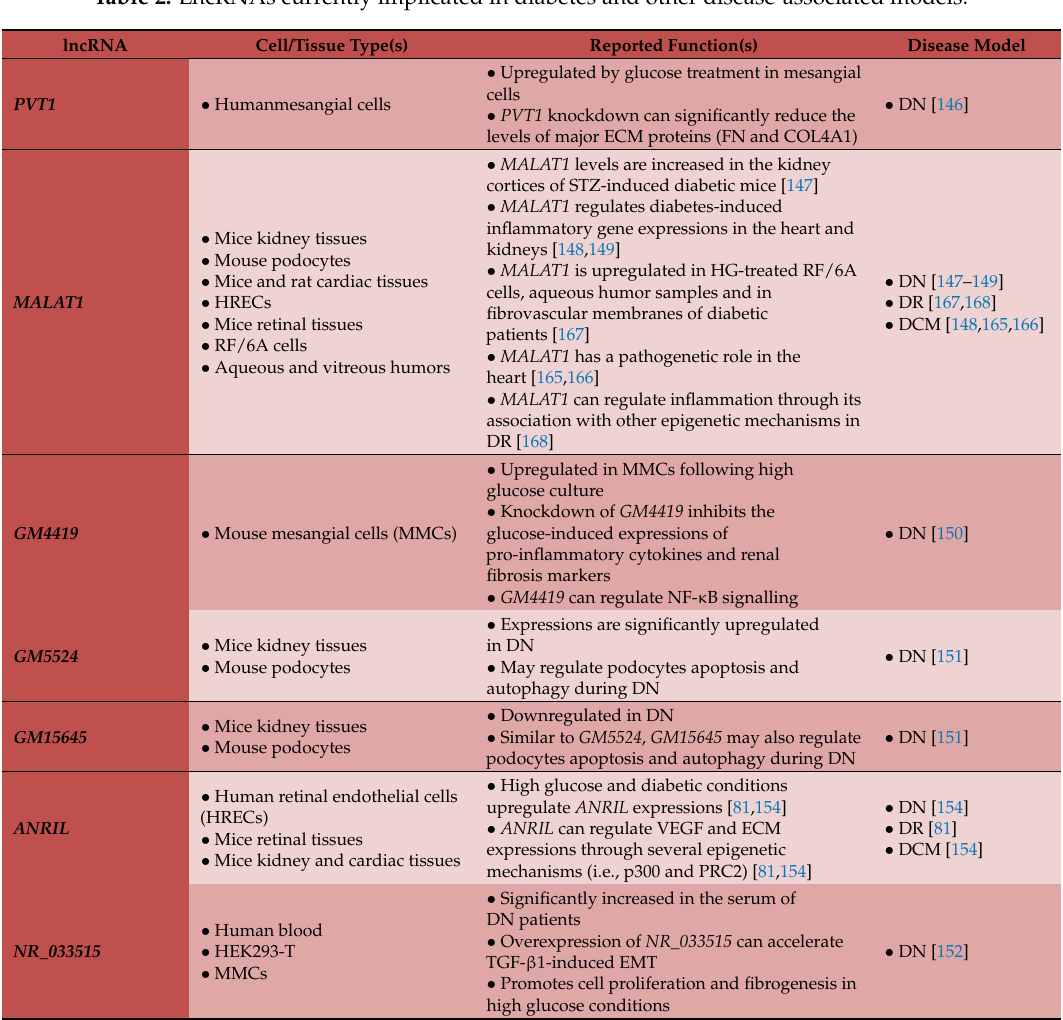
Table 2. LncRNAs currently implicated in diabetes and other disease-associated